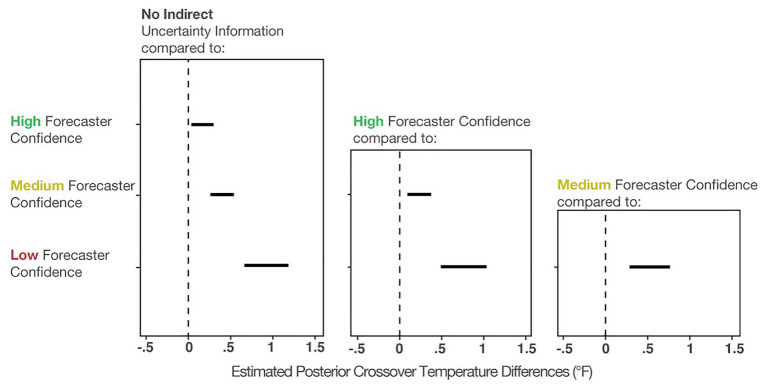
The 95% credible intervals for the comparisons between each forecast confidence condition.